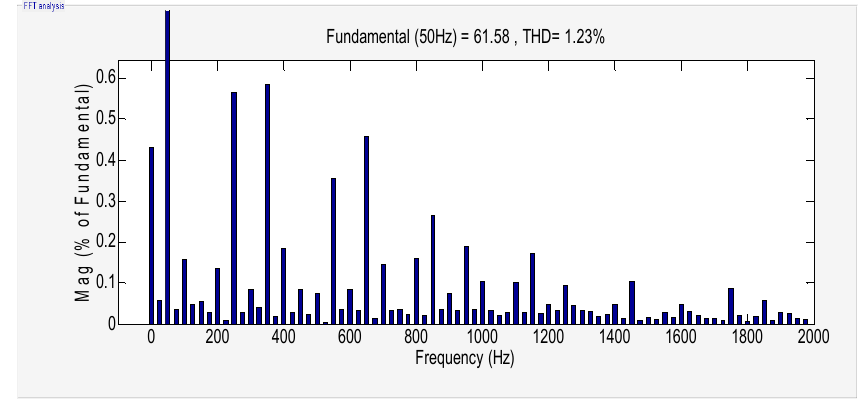
Figure 9. Harmonic spectrum of the source current at 0.06 s.